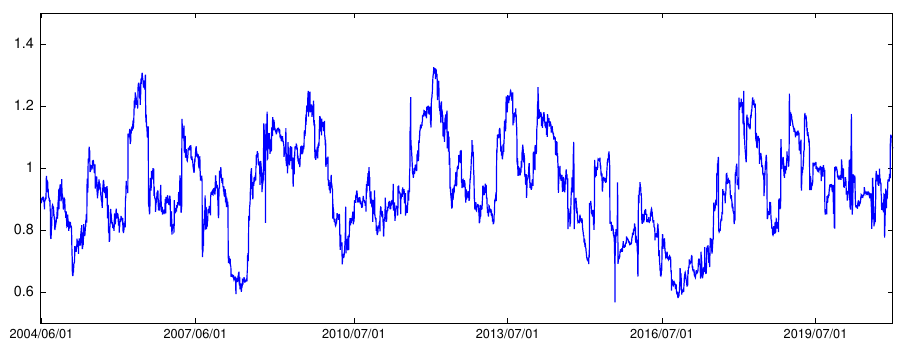
Figure 2. Ratios between return variance and RV average of DIS in 100-days rolling